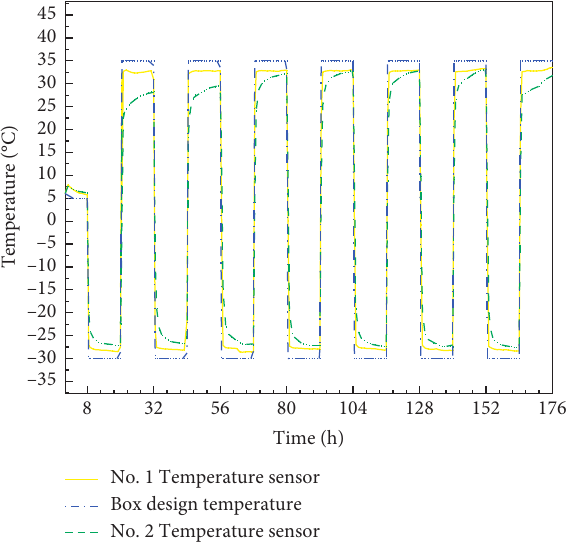
Figure 5: Box temperature during freezing-thawing